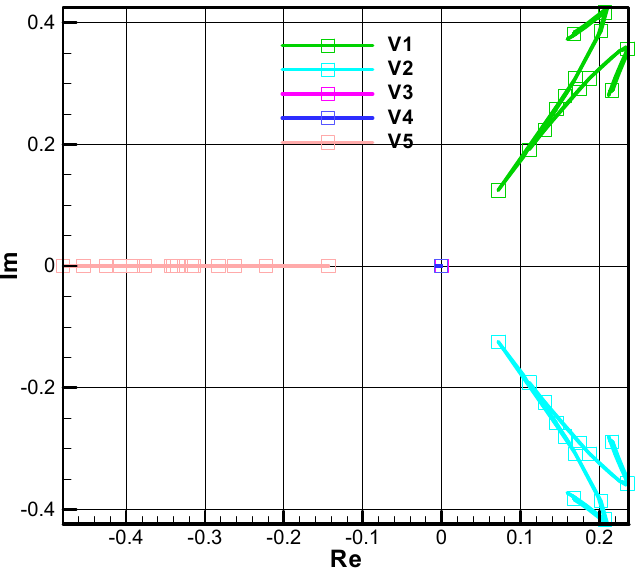
Figure 9. Eigenvalues of the stability matrix A for longitudinal motion in ascending/descending evolution.